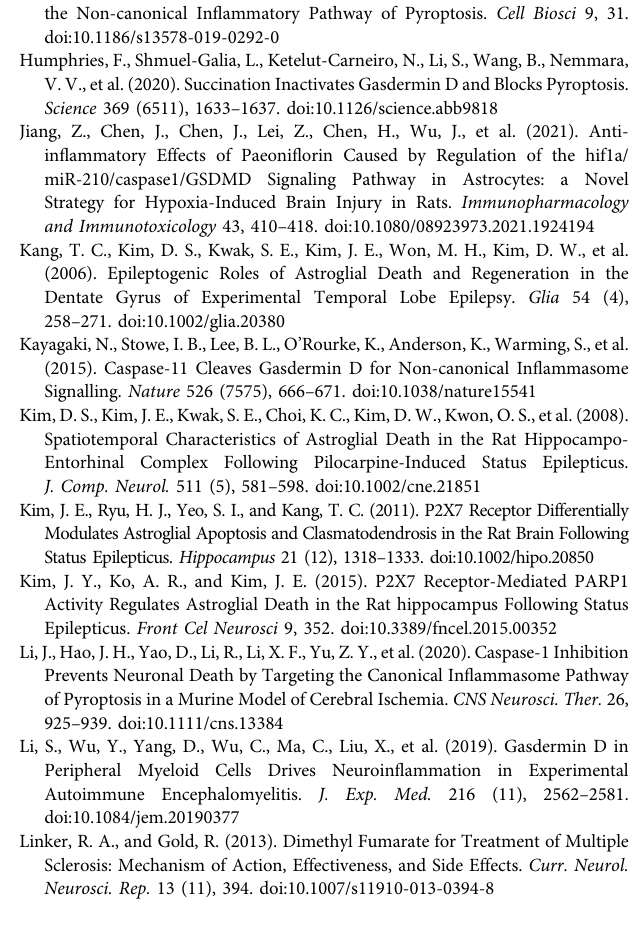
Supplementary Figure S3 | DMF had no signi fi cant in fl uence on the astrocytes in the CA3 and DG regions. (A) Astrocytes without clasmatodendrosis at